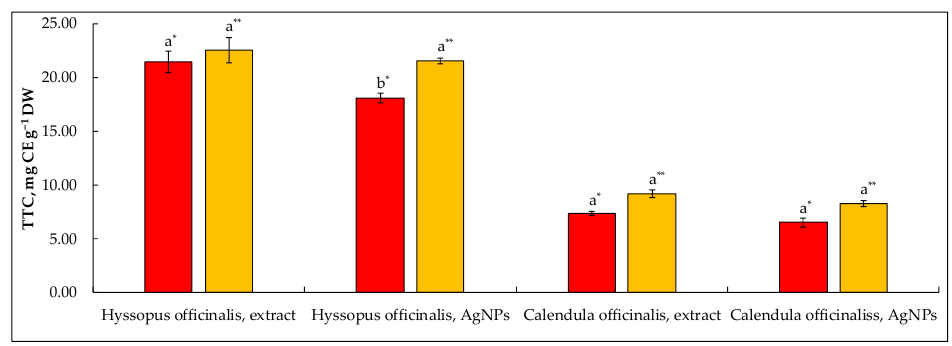
Figure 2. The amount of total tannins in Hyssopus and Calendula water extracts and their mediated silver nanoparticles according to the determination method (H 2 O and MeOH used as diluent). Note: Values are means ± SD of triplicates (n = 3). Means within the same plant material and diluent (H 2 O* or MeOH**) with different superscript letters ( a,b ) are significantly different (one-way ANOVA and Tukey’s test, p ≤ 0.05). SD— standard deviation; DW — on a dry weight basis.